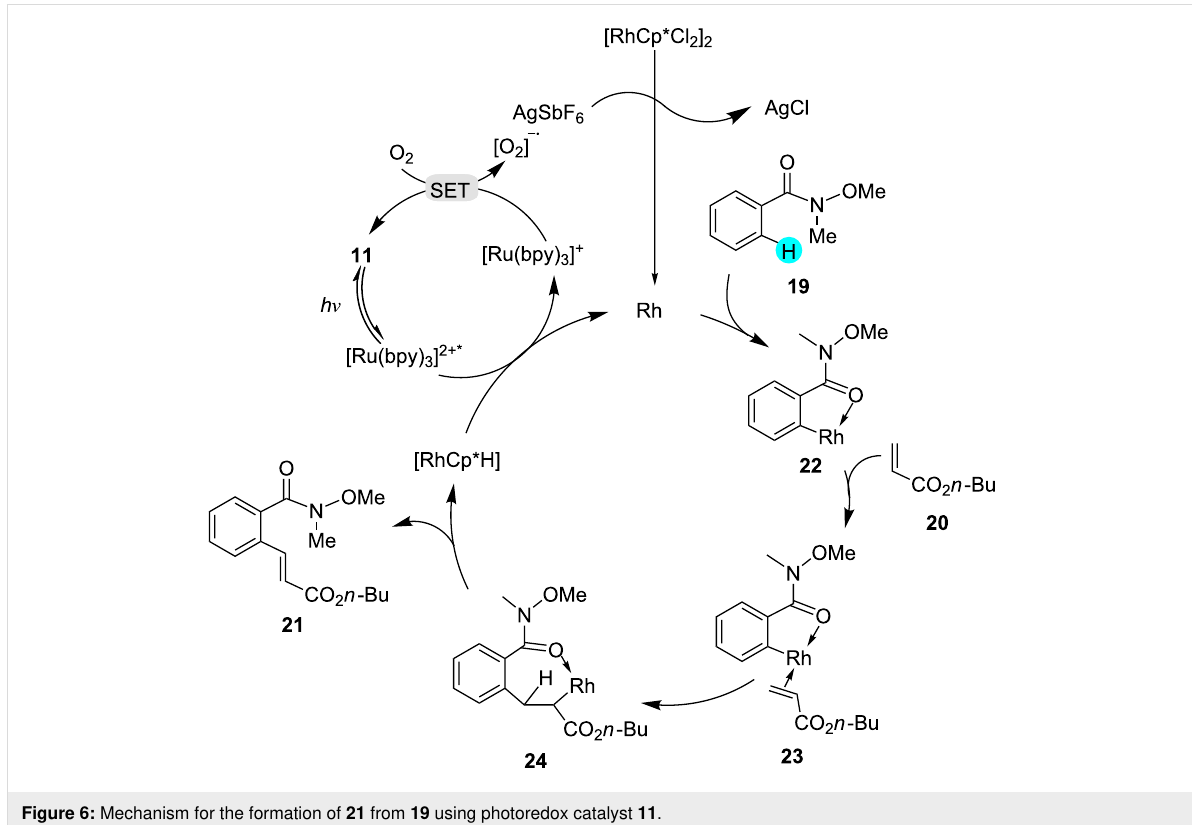
Figure 6: Mechanism for the formation of 21 from 19 using photoredox catalyst 11 .